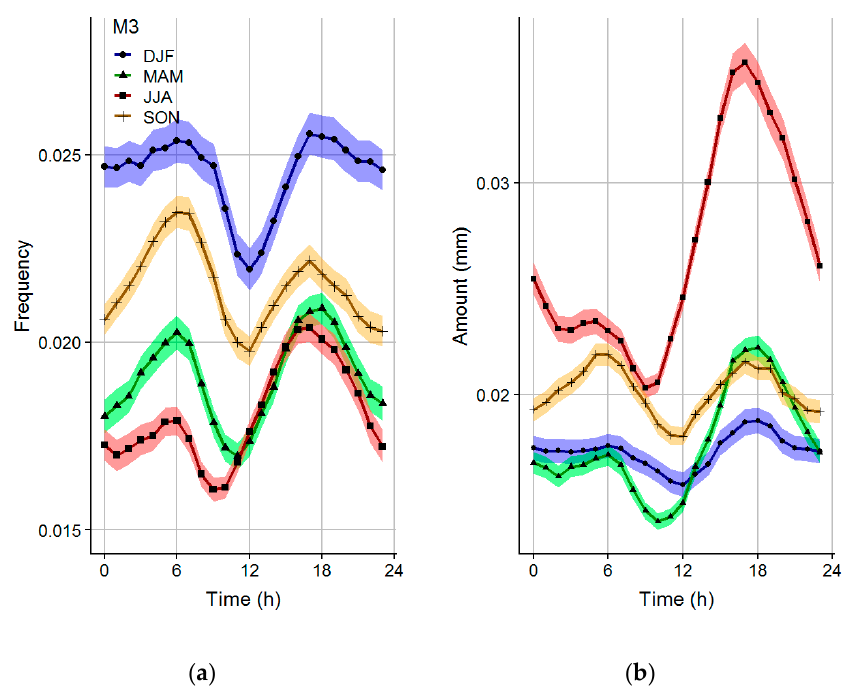
Figure 3. Precipitation diurnal cycles (PDC) for each season represented by the long-term averages of ( a ) the hourly precipitation occurrence frequency and ( b ) the hourly precipitation amount with the shaded 95% confidence intervals.